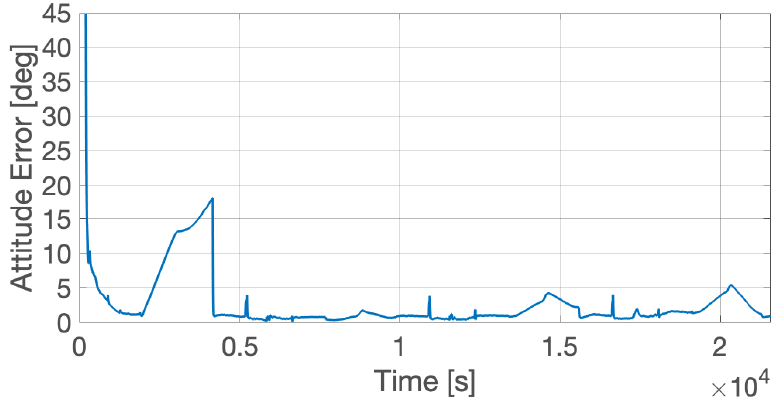
Figure 5. Attitude error in MIL analysis of Earth pointing AODS, with continuous nadir rotation to align solar arrays.